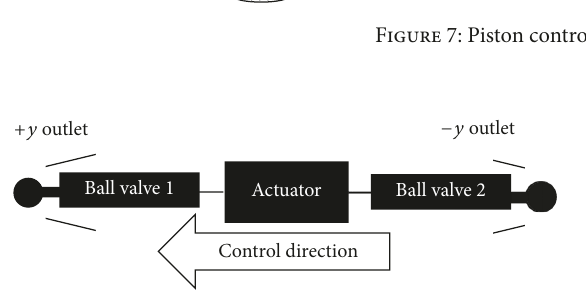
Figure 8: Actuator schematic linked to two ball valves on the same axis.